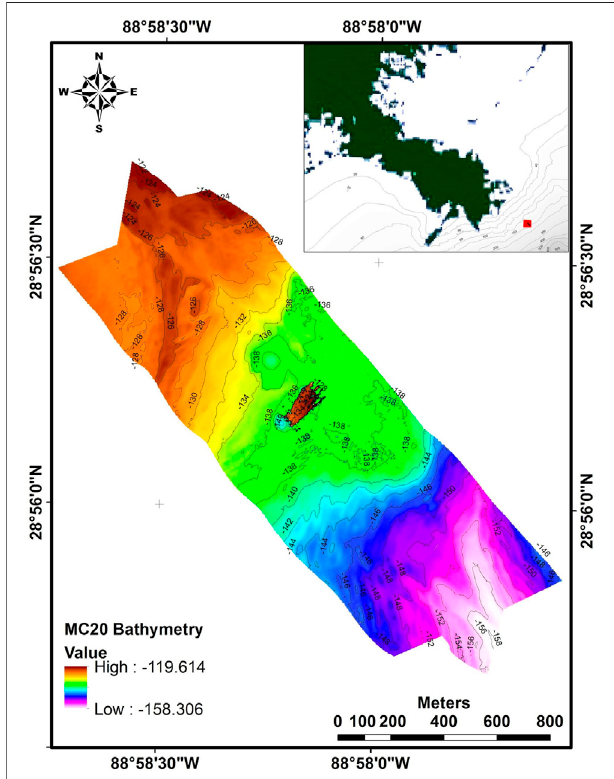
FIGURE1| StudyareaisthesiteofthesunkenTaylorEnergyplatformin the northern Gulf of Mexico in the MC20 lease block (red square) approximately 18 km southeast of the Mississippi River Delta, original Fig. 2.1 (Mason et al., 2019).